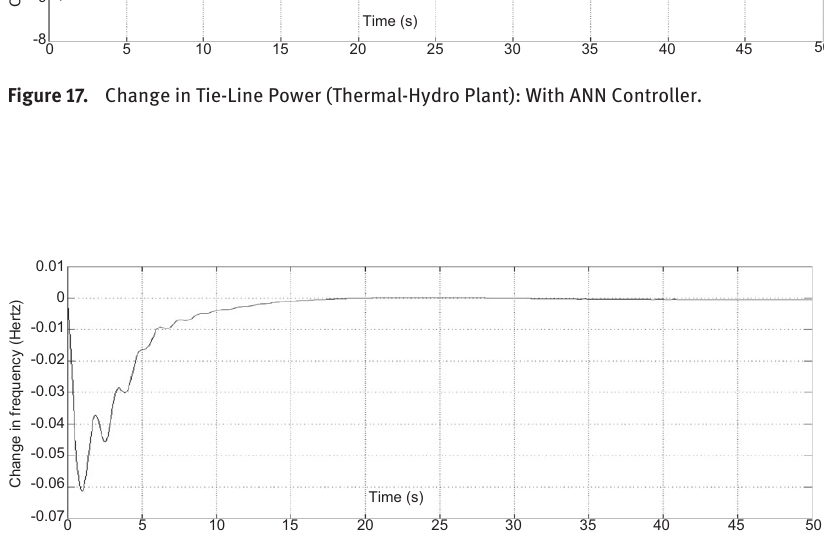
Figure 18. Change in Frequency (Thermal Plant): With ANFIS